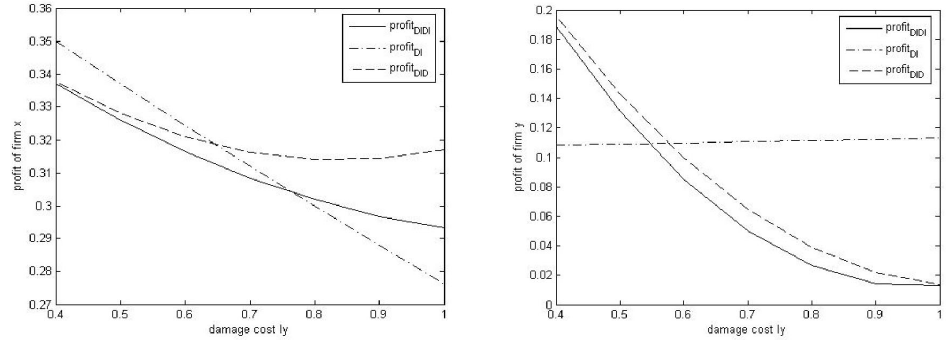
Figure 2. The comparison of π x and π y between scenario DIDI, DI and DID ( l x = 0.25 l y )